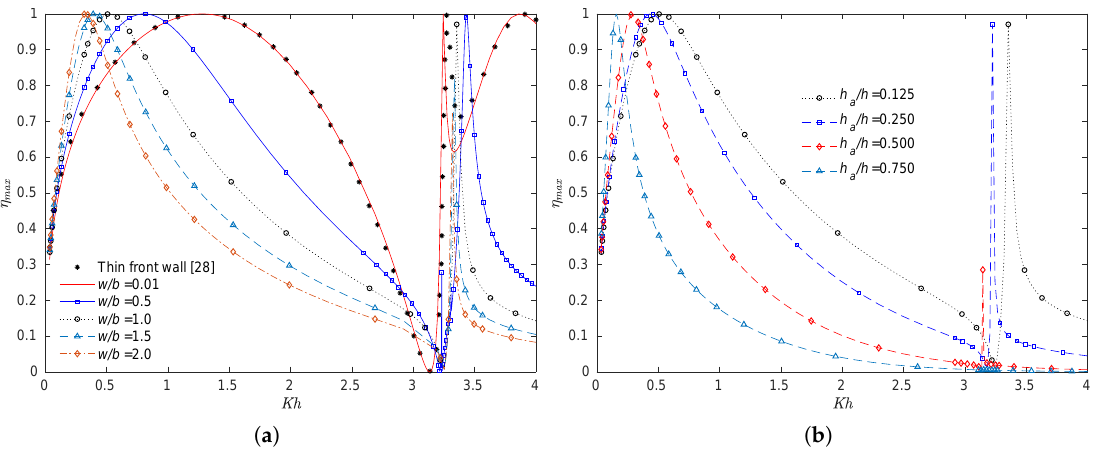
Figure 6. Hydrodynamic efficiency versus Kh . ( a ) For various thickness ratios w / b with h a / h = 0.125 and b / h = 1.0. ( b ) For different submergence ratios h a / h with w / b = 1.0 and b / h =